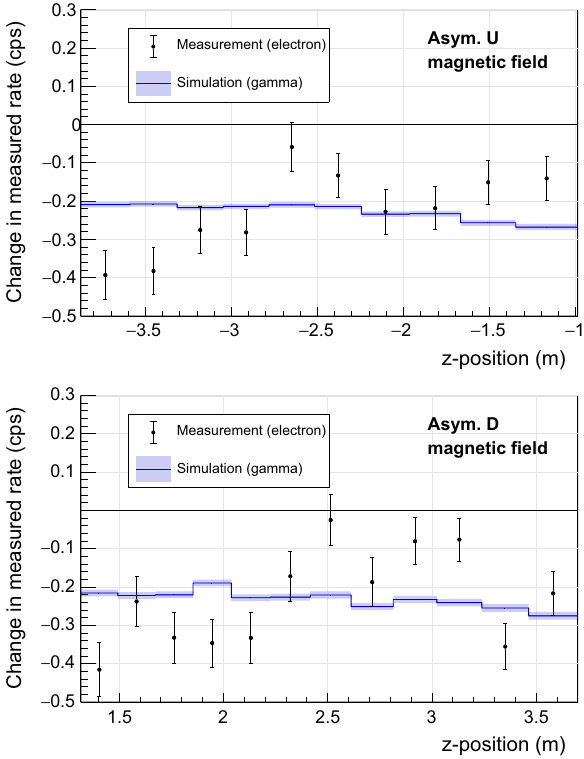
Fig. 9 The reduction in the electron rate at the inner surface of the MS, caused by the water shielding, for two asymmetric mag- netic field settings. The region shielded by the water tanks is roughly z = − 6 . 5 m to 6 . 5 m. The simulated decrease in the gamma flux is also shown in each figure, normalized to the measured rate. The error bars for the measurement and simulation data are statistical only